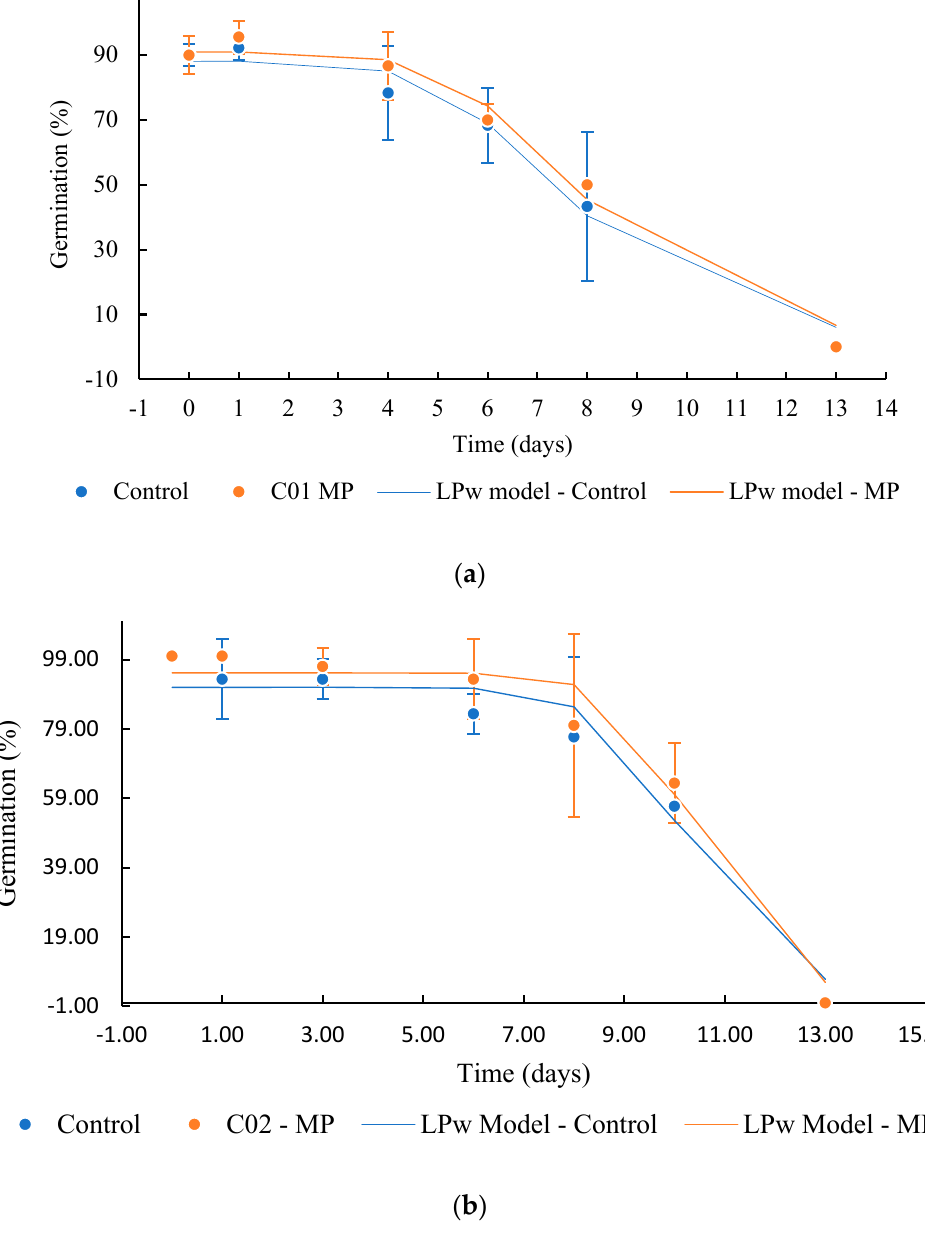
Figure 10. Survival curve of soybean seeds stored at the temperature of 42 °C ± 1 and 75% RH. ( a ) Cultivate C01, ( b ) cultivate C02. The logistic power model (LPw) was used to adjust the curve behavior. The error bar indicates the standard deviation ( n = 3).